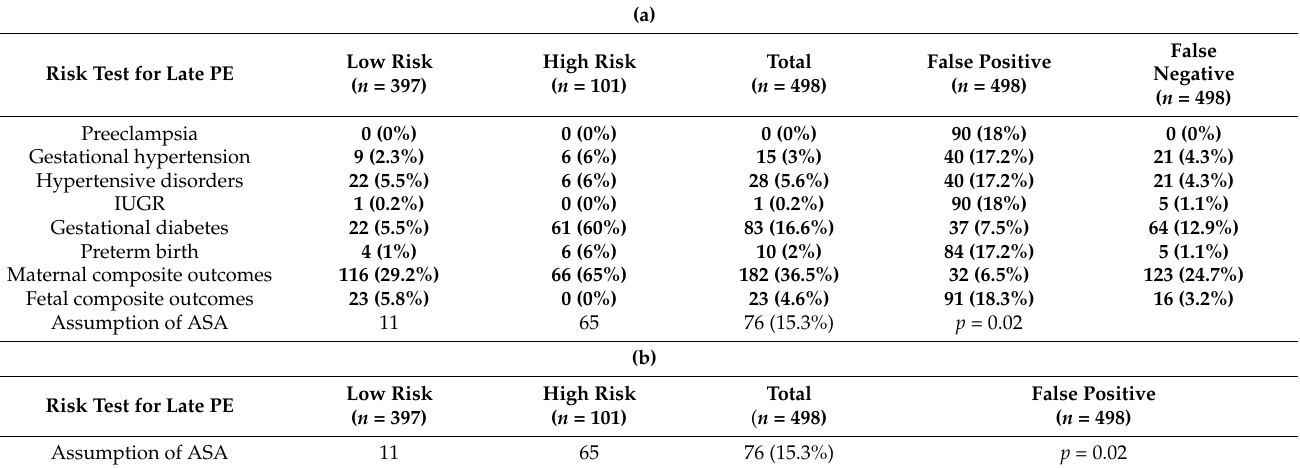
Table 7. (a) Incidence of outcomes based on the risk of late PE. (b) Incidence of ASA intake based on late PE